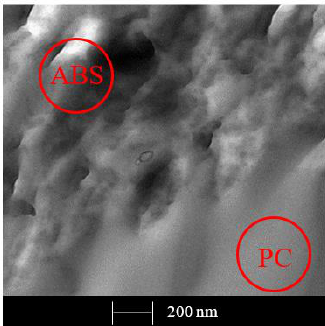
Figure 10. TEM micrograph of pristine PC/ABS blend.